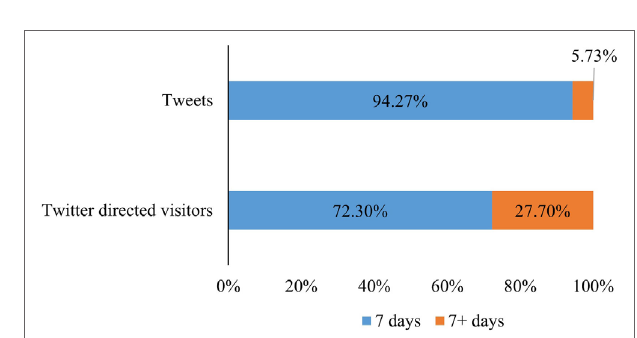
FigUre 4 | Correlation between Facebook shares and Tweets (Log transformation).